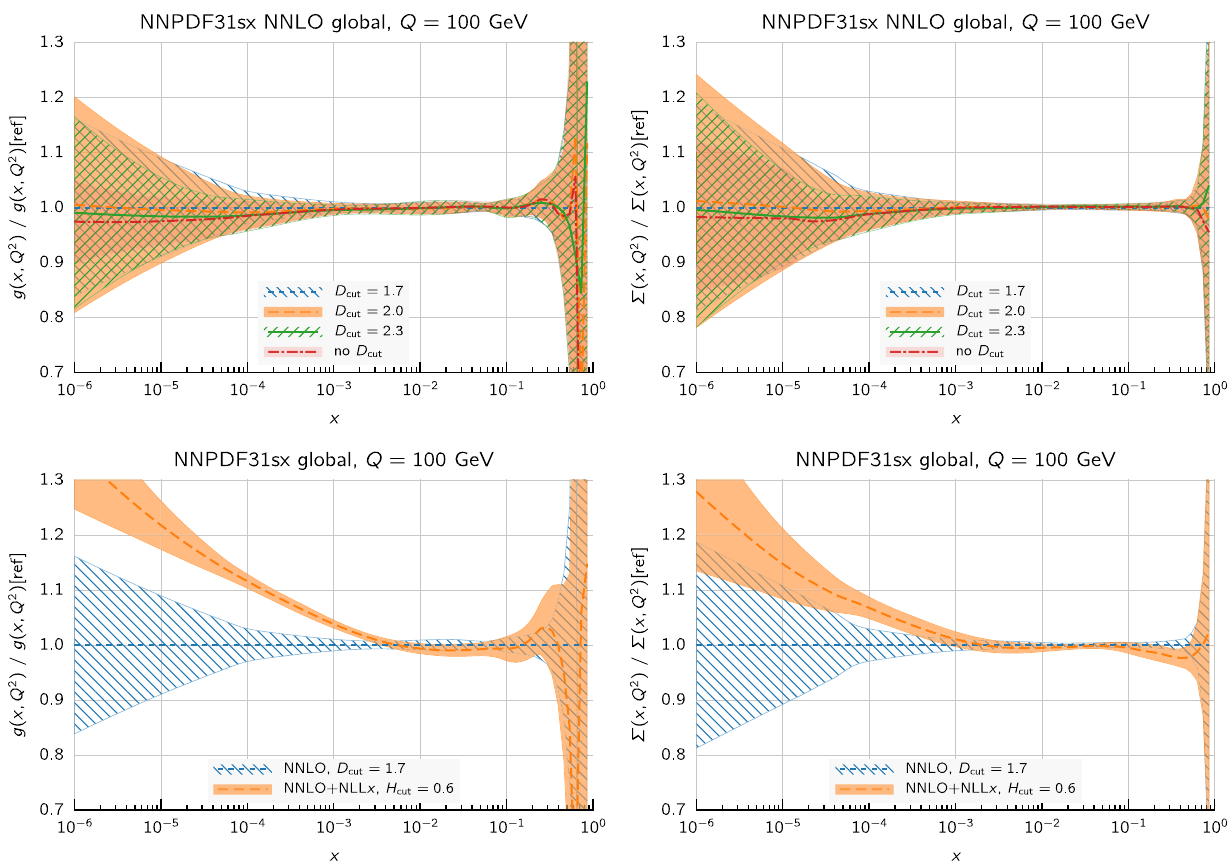
Fig. 28 Upper plots: comparison between the gluon and quark singlet at Q = 100 GeV from the NNPDF3.1sx NNLO fits with various values of D cut with the corresponding fit without that kinematic cut. Bottom